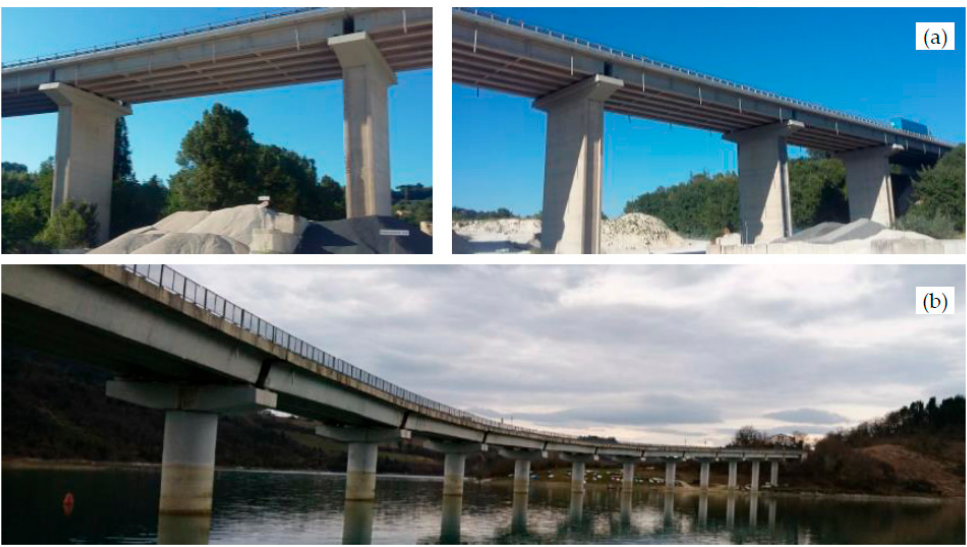
Figure 2. Bridge case studies: ( a ) the B1 and ( b ) the B2 bridge.